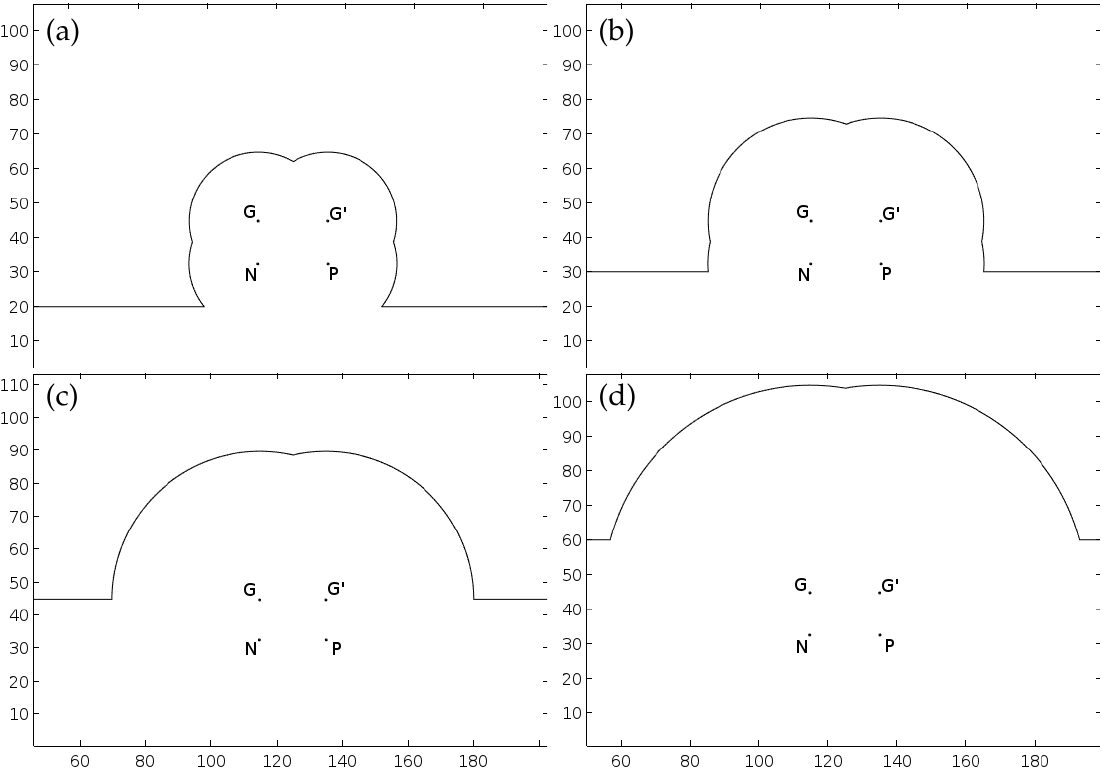
Figure 4. Analysis as given by the Electrogeometric Model on the span region of a conventional HVDC line topology. ( a ) I p = 2.9 kA, ( b ) 5.4 kA, ( c ) 10.1 kA and ( d ) 15.7